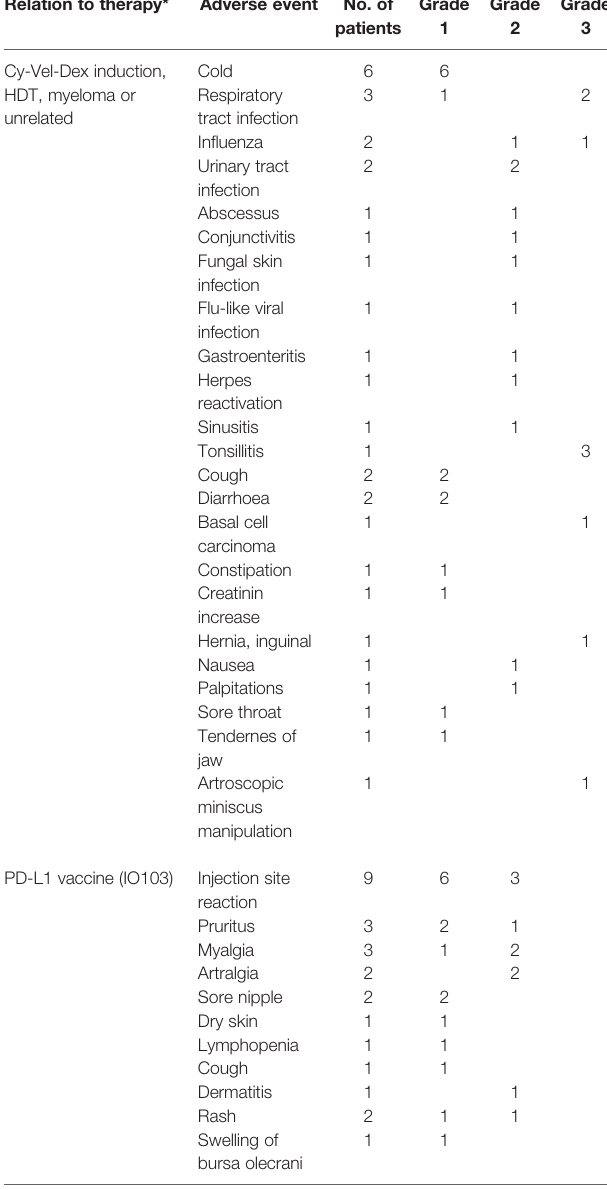
TABLE 2 | AEs total adverse events during